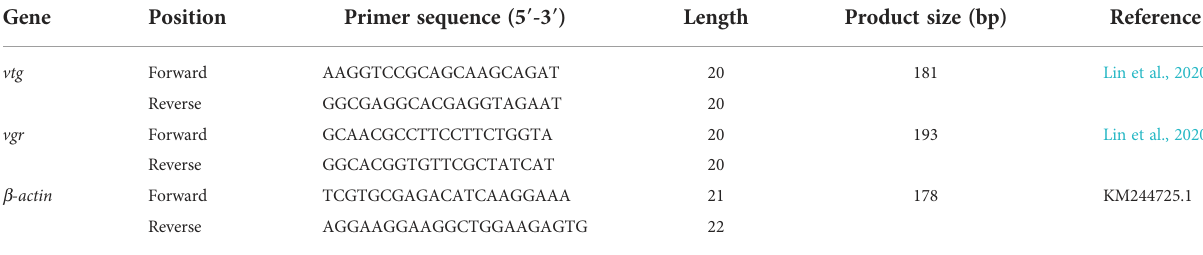
TABLE 2 Nucleotide sequences of the primers for real-time quantitative PCR.